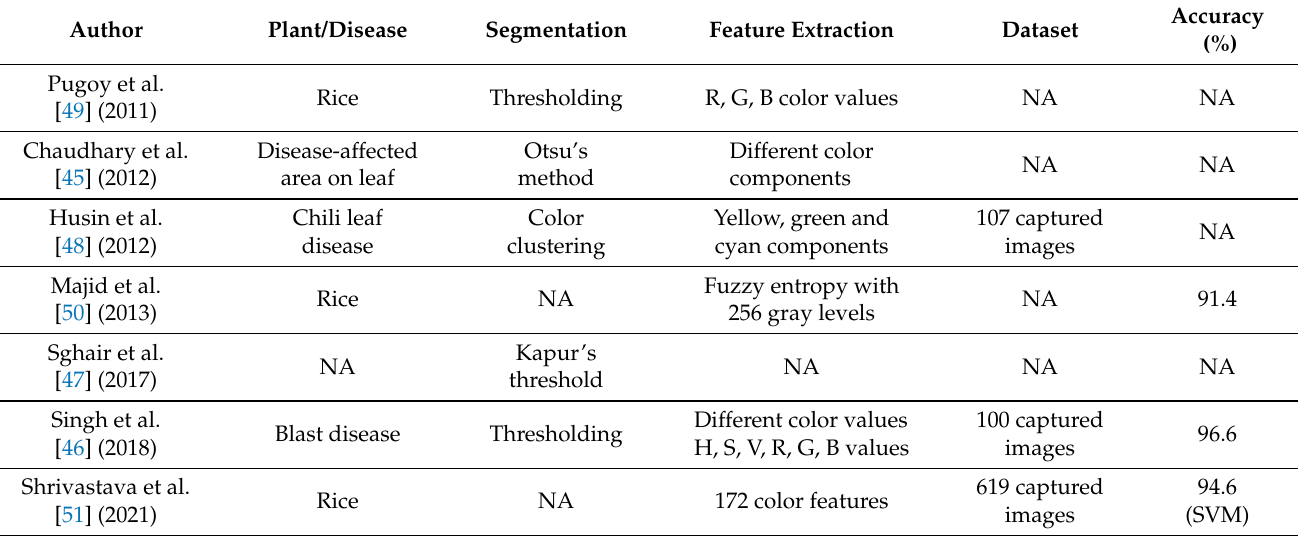
Table 2. Summary of implemented details along with features based on color based